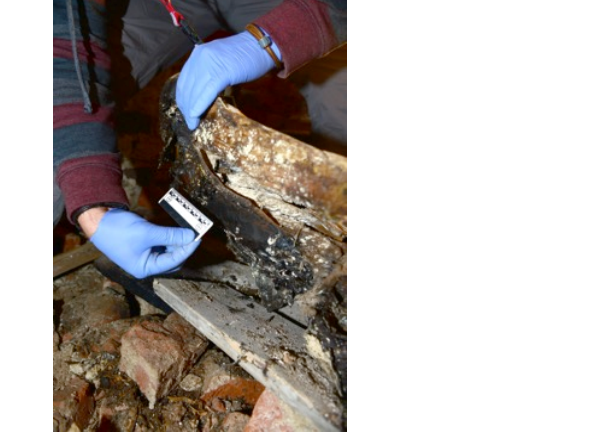
Figure 5. Thermo-visual survey (author: D. Dajek). A bioarchaeological survey demonstrated that the high moisture level had a negative impact on the naturally mummified remains belonging to the members of the von Fahrenheid family buried in the tomb (Wi ę ckowski 2016) (Fig. 6).